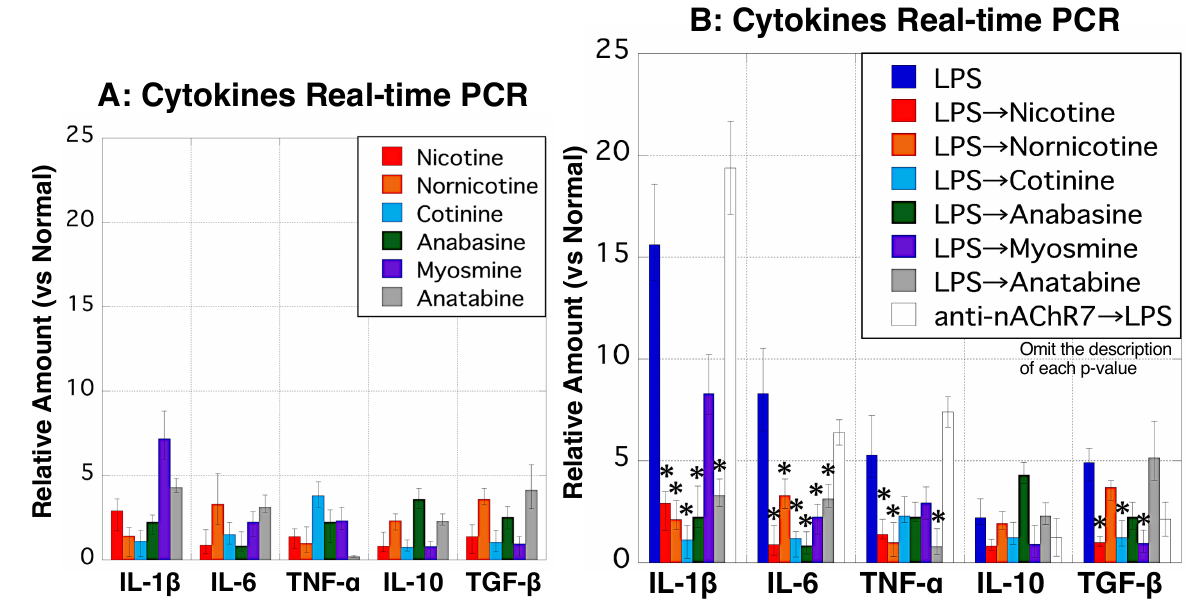
Figure 12. Cytokine mRNA expression in rat peritoneal M Φ . Real-time PCR was conducted to detect cytokines in M Φ . ( A ) The y -axis indicates mRNA expression levels of IL-1 β , IL-6, TNF- α , IL-10, and TGF- β in M Φ treated with 10 µ g/mL of nicotine (red), nornicotine (yellow), cotinine (light blue), anabasine (green), myosmine (purple), and anatabine (gray), relative to normal conditions (no stimulation). ( B ) The y -axis indicates the mRNA expression levels of five cytokines in M Φ treated with 10 µ g/mL of LPS (blue) or M Φ stimulated with nicotine (red), nornicotine (yellow), cotinine (light blue), anabasine (green), myosmine (purple), and anatabine (gray), after pretreatment with 10 µ g/mL LPS. In addition, the condition in which M Φ pretreated with 10 µ g/mL anti-nAChR7 and then stimulated with 1.0 mg/mL of LPS was added (white). Data values are presented as the median ± max/min. * p < 0.05 (vs. LPS treated M Φ ). IL-1 β , interleukin-1 β ; IL-6, interleukin-6; IL-10, interleukin-10; M Φ , macrophages; nAChR7, α 7 nicotine acetylcholine receptor; TGF- β , transforming growth factor- β ; and TNF- α , tumor necrosis factor- α